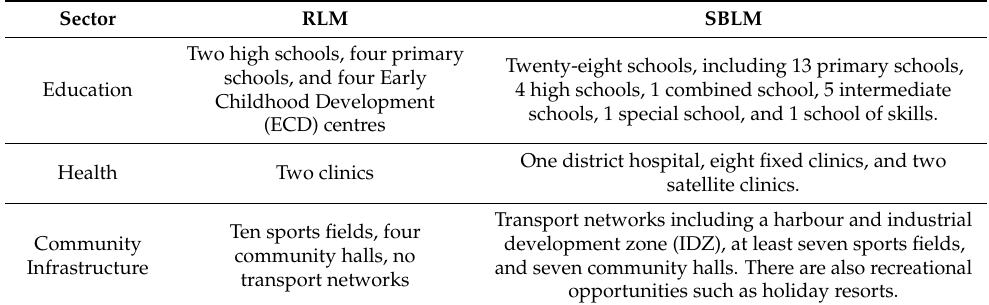
Table 7. Number of institutions per sector in RLM and